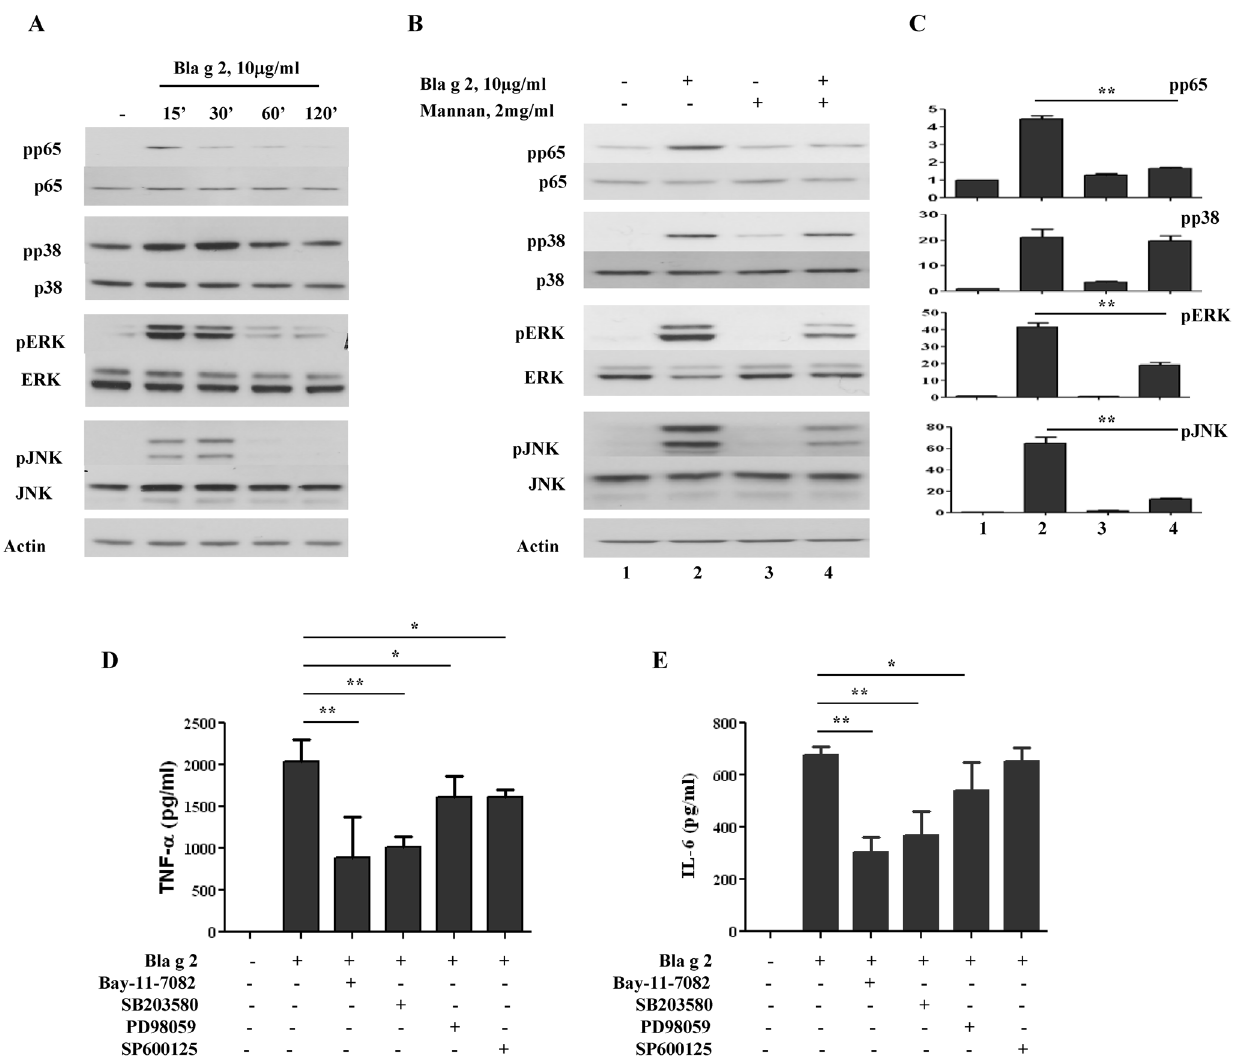
Figure 6. Bla g 2 induced NF-kB, ERK, and JNK activation through CD206 in fibrocytes. ( A ) Fibrocytes were treated with Bla g2 (10 m g/ml) at indicated times, and cell lysates were harvested for the detection of phospho-p38 MARP, p65, ERK, and JNK. ( B–C ) Fibrocytes were treated with Bla g 2 (10 m g/ml) or pretreated with mannan (2 mg/ml) for 1 h and cell lysates were harvested at 30 min for Western blotting with the indicated antibodies ( B ). The levels of phosphorylated proteins were quantified and normalized to those of b -actin (n=3), and fold changes were generated when fibrocyte treated groups with either Bla g 2 or mannan was compared to the group without treatment ( C ). ( D–E ) Fibrocytes were treated with Bla g 2 (10 m g/ml) or pretreated with 5 m M inhibitors for NF-kB (Bay-11-7082), p38 (SB203580), ERK (PD98059), and JNK (SP600125) for 1 h at 37 u C before Bla g 2 treatment. Levels of fibrocyte secreted TNF- a at 6 h ( D ) and IL6 at 24 h ( E ) in supernatant were detected using ELISA. Data are mean 6 SD of three individual experiments. * P , 0.05, ** P ,